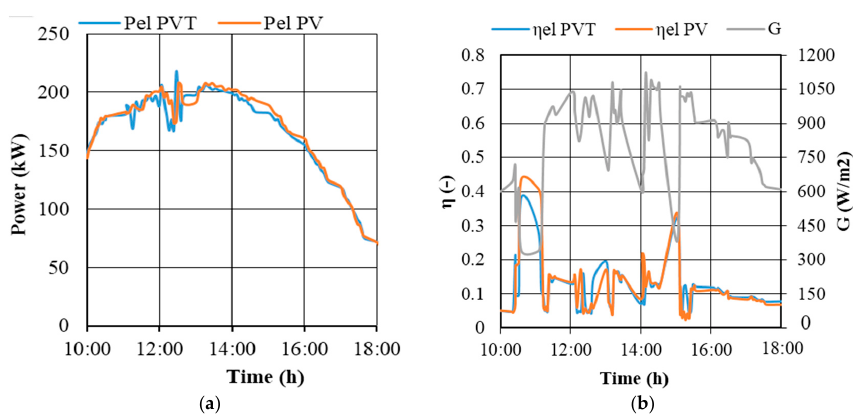
Figure 12. PVT collector and PV panel daily power ( a ) and efficiency ( b ).